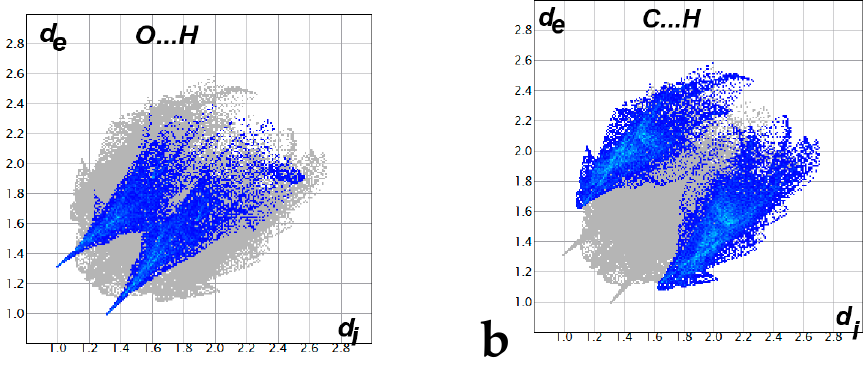
Figure 6. The decomposed fingerprint plots of the strong O...H ( a ) and weak C ... H ( b ) contacts.